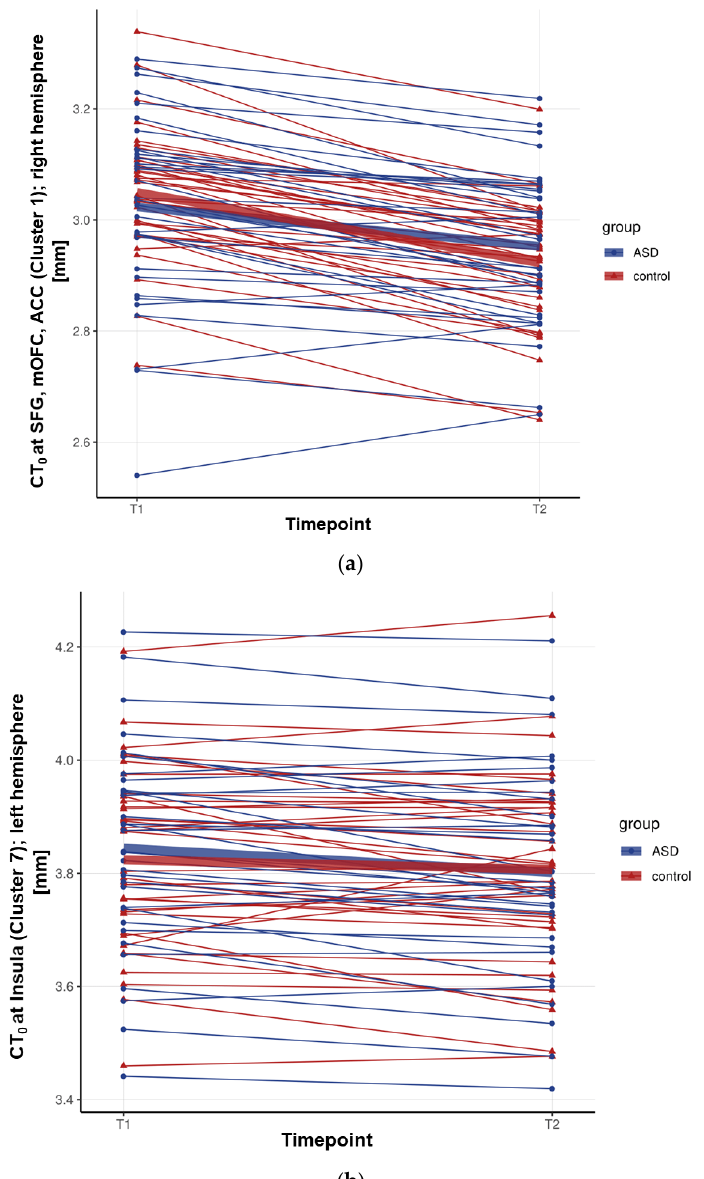
Figure 3. Cluster-wise mean Cortical Thickness (CT) at timepoint 1 (T1) and timepoint 2 (T2). Cluster-wise estimates of the mean CT of individuals at T1 and T2 for the clusters in which a significant between-group difference was observed between individuals with autism spectrum disorder (ASD) (marked in blue) and typically developing (TD) controls (marked in red) in the main analysis, i.e., the main effect of the group for a developmental change in CT. Displayed are two clusters, ( a ) cluster 1 is an example of the first six clusters out of seven, in which, overall, developmental cortical thinning was more pronounced in TD controls as compared to individuals with ASD; and ( b ) cluster 7, which was the only cluster, where individuals with ASD, overall, showed more pronounced developmental cortical thinning relative to TD controls. Abbreviations: SFG: superior frontal gyrus; mOFC: medial orbital frontal cortex; ACC: anterior cingulate cortex.